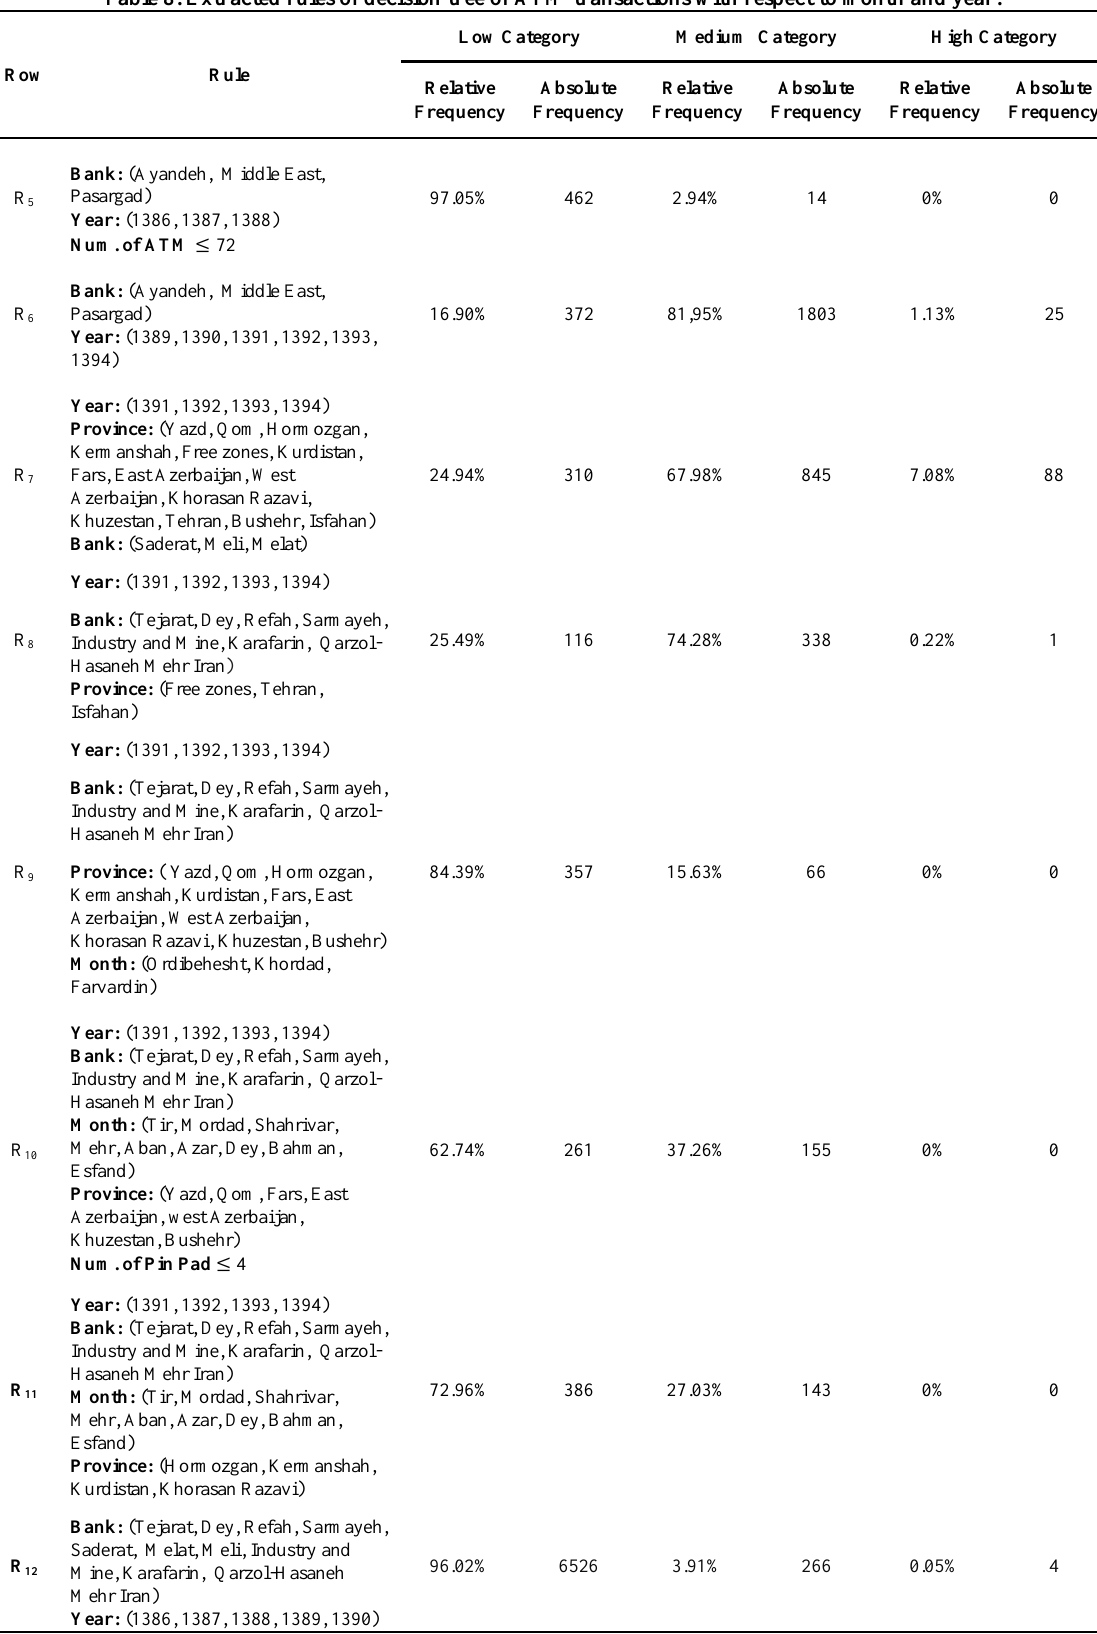
Table 8. Extracted rules of decision tree of ATM transactions with respect to month and